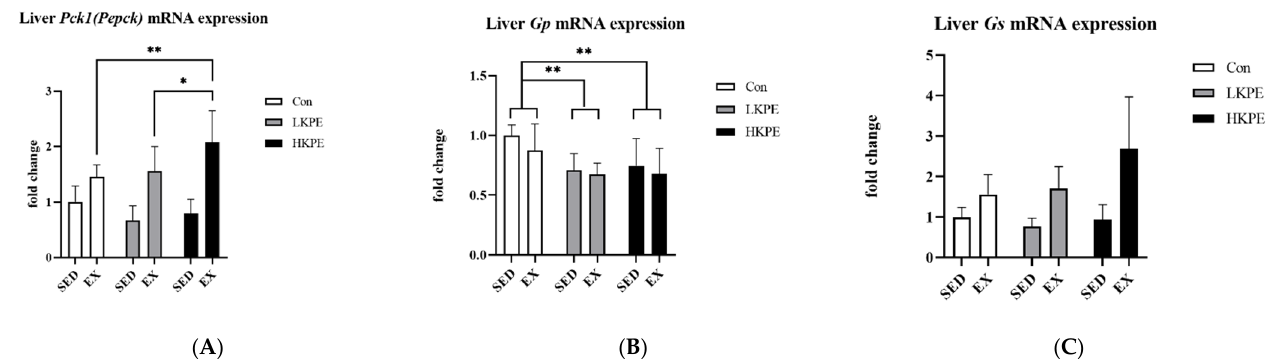
Figure 7. mRNA expression of ( A ) Slc2a4 (Glut4) , ( B ) Pfkm , ( C ) Hk2 , ( D ) Gs , and ( E ) Gp in gas- trocnemius muscle immediately after exhaustion. Gs , glycogen synthase; Gp , glycogen phosphory- lase; Pfkm , 6-phosphofructokinase muscle type; Hk2 , hexokinase 2; Slc2a4 (Glut4), solute carrier fam- ily 2 (facilitated glucose transporter); SED, sedentary; EX, exercise; Con, control; KPE, Kaempferia parviflora administration; ns, no significance observed; * p < 0.05, ** p < 0.01, *** p < 0.001.